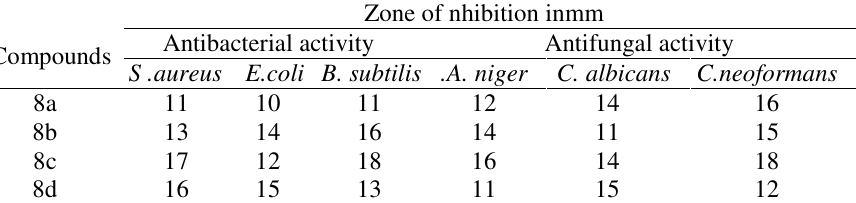
Table 1 . Biological activity